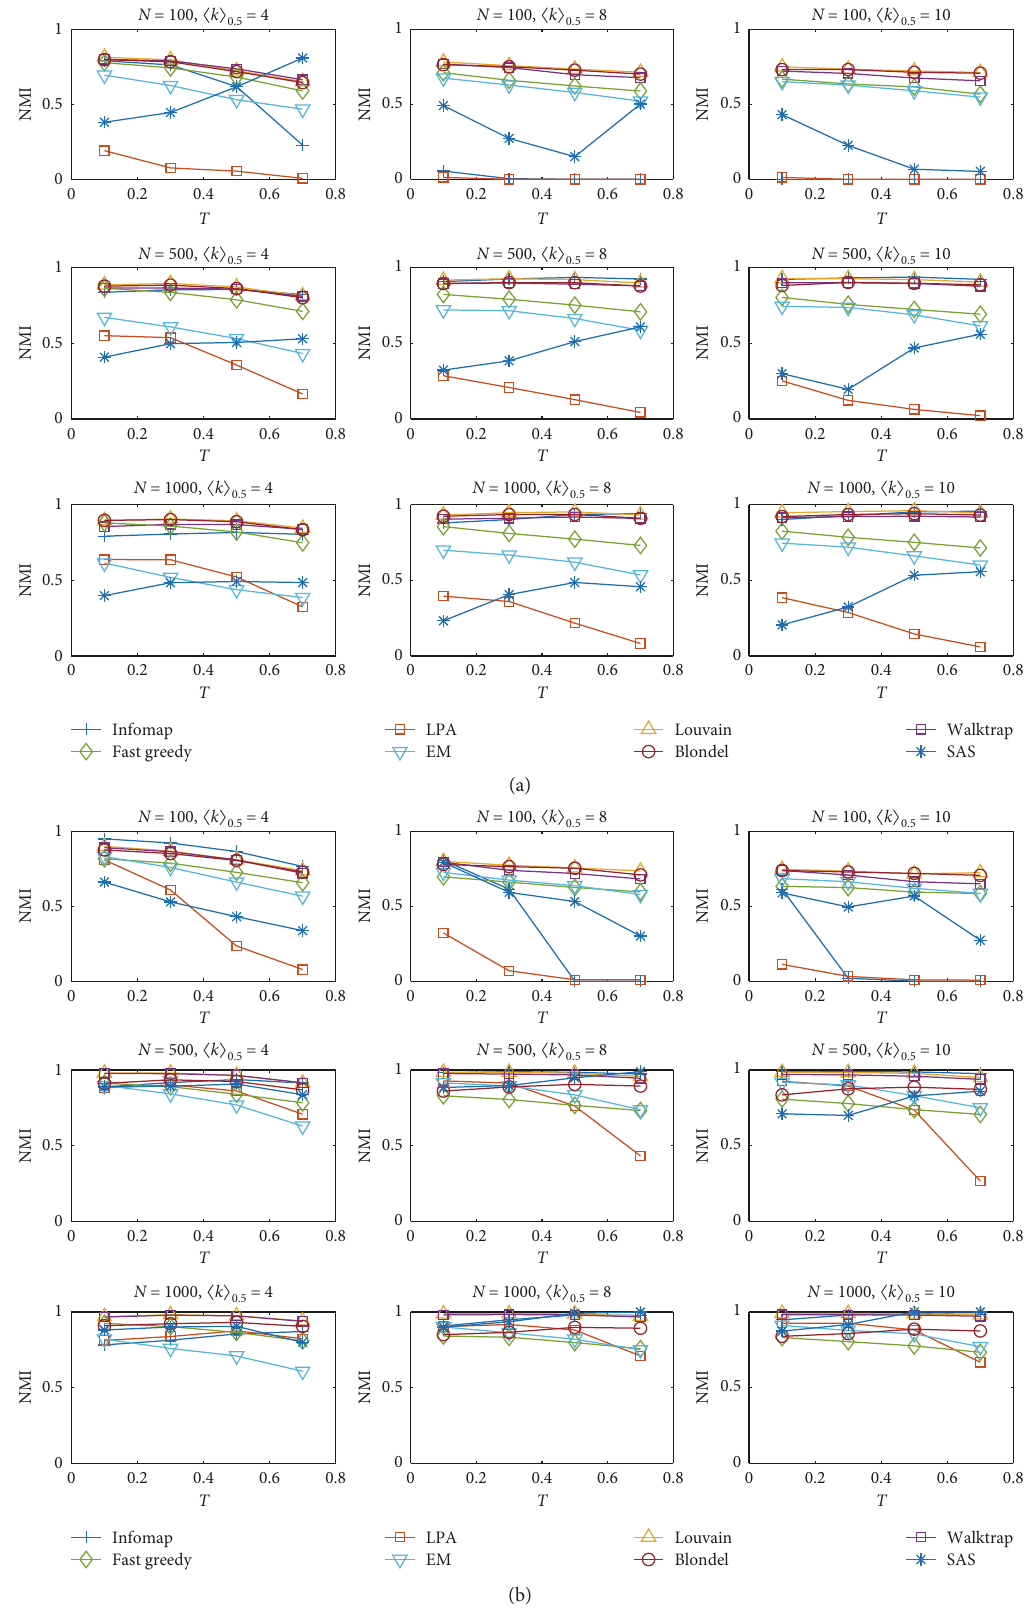
Figure 10: Community detection on nPSO networks. The number of communities n Figure